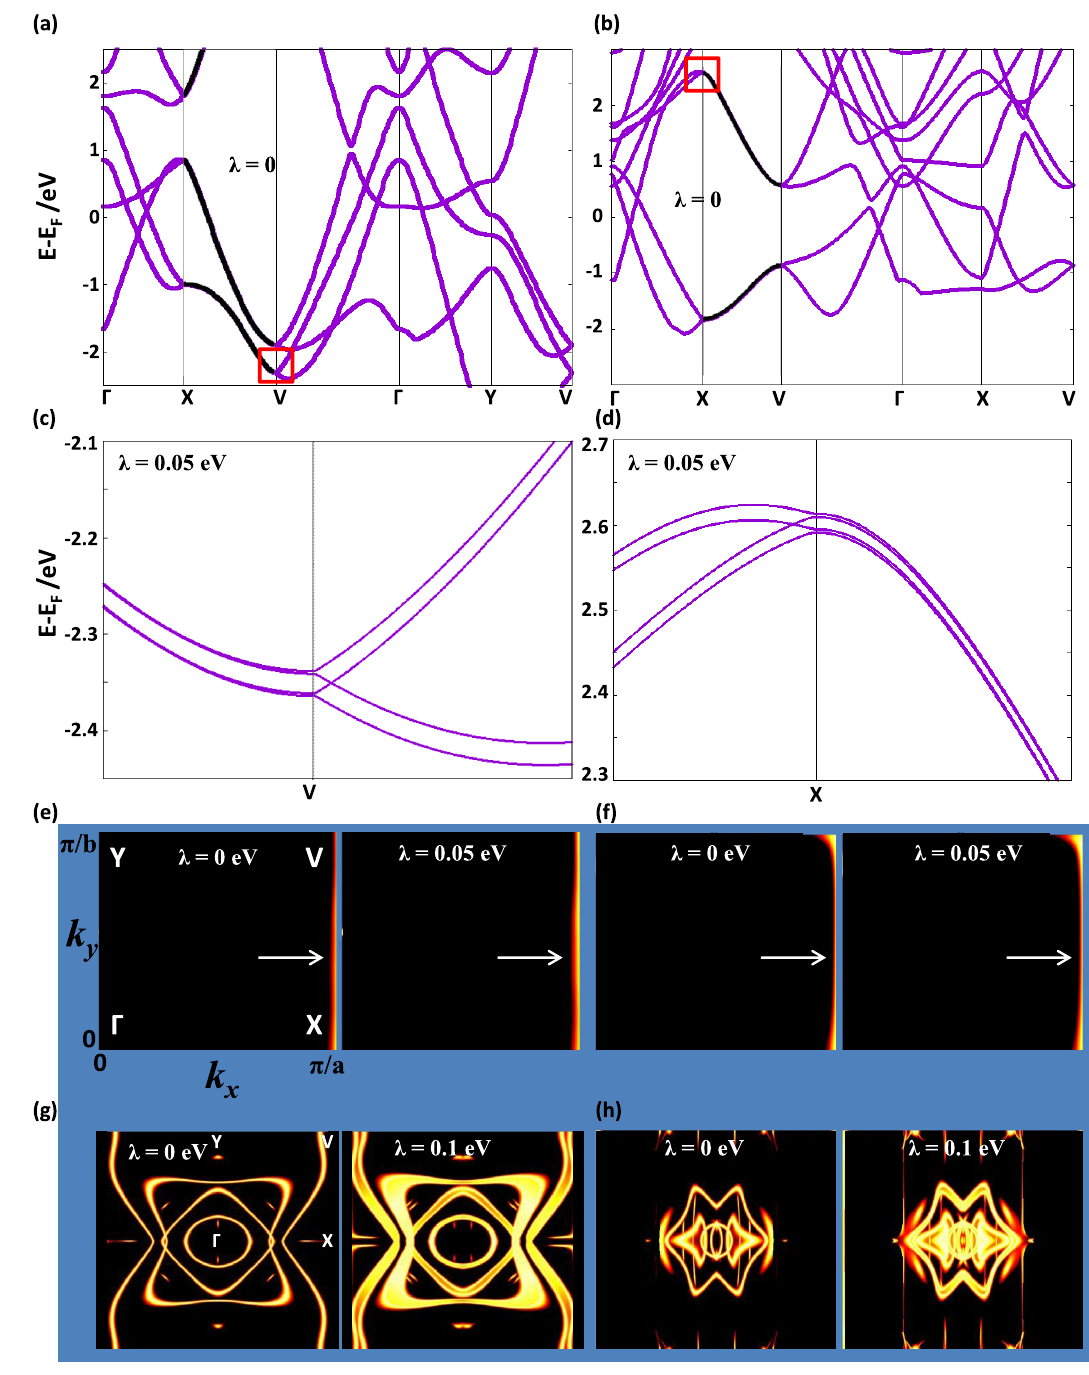
0 eV) along the Ŵ Figure 5. ( a,b ) Band structure of B 10 [B 16 ] without Rashba spin-orbit coupling (SOC) ( (cid:31) = -X-V- Ŵ -Y-V path in the Brillouin zone, with the position of points Ŵ , X, V, and Y given in the left panel of ( e ). The symmetry-enforced nodal lines along the X-V direction are highlighted in black. ( c,d ) Amplified image of 0.05 eV). Each fourfold the bands inside the red rectangles in ( a,b ), but in the presence of Rashba SOC ( (cid:31) = degenerate symmetry-enforced nodal line splits into a pair of spin-split twofold degenerate nodal lines. ( e,f ) 0 Contour plot of the symmetry-enforced nodal lines shown in ( a,b ) without Rashba SOC in the left panel ( (cid:31) = 0.05 eV). The nodal lines, which are pinned at eV) and in the presence of Rashba SOC in the right panel ( (cid:31) = π/ a of the Brillouin zone, are indicated by arrows. ( g,h ) Contour plot of all accidental nodal lines the edge k x = which exist within an energy window of 2.0 eV about the Fermi energy in the band structure shown in ( a,b ), 0 eV) and in the presence of Rashba SOC in the right panel ( (cid:31) 0.1 without Rashba SOC in the left panel ( (cid:31) = =